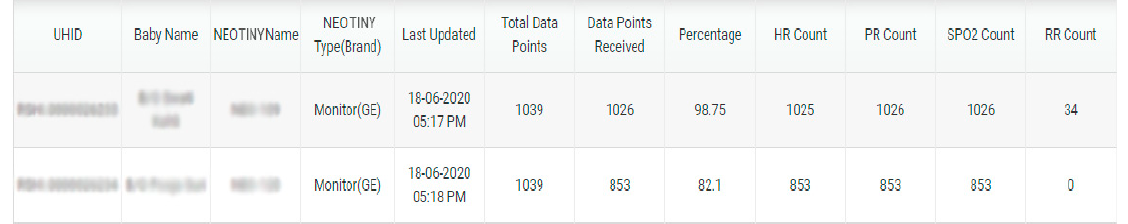
Figure A7. Vital tracking data monitoring screen (‘Total Data Points’ refer to the data points expected by the time of the last update, and ‘Data Points received’ refers to data points received in actual.).